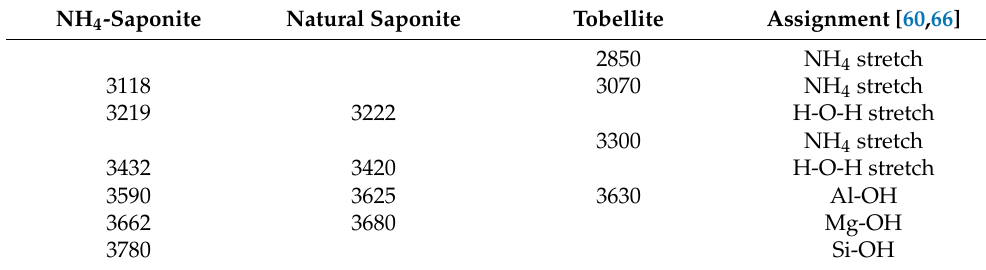
Figure 8. Mid-IR spectra in the region between 1900 and 400 cm − 1 of NH 4 -saponites synthesized with different H 2 O/(Si + Al) ratios (modified after [57]). Table 2. Band positions (cm − 1 ) based on band deconvolution and suggested assignments for the hydroxyl-stretching region of the infrared spectra of synthetic NH 4 -saponite in comparison to natural saponite and